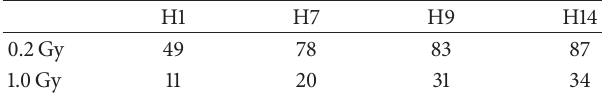
Table1:Percentofcellswhichsurvivedat24hoursafterIRexposure relative to the unexposed